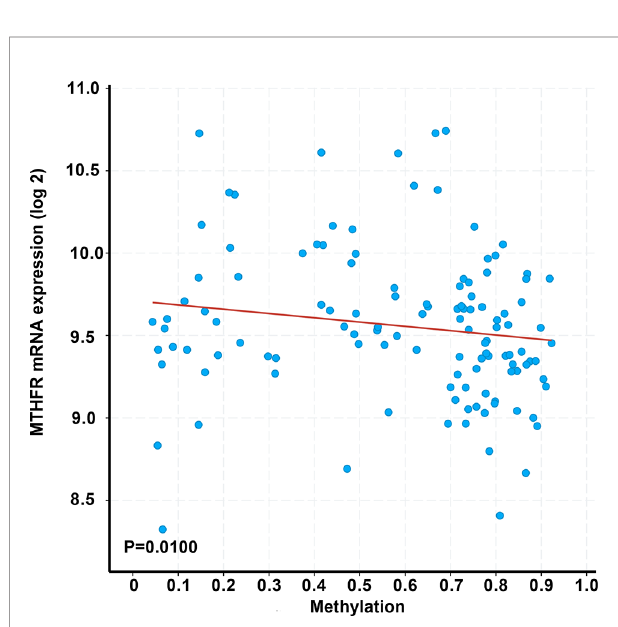
FIGURE 4 | Correlation between MTHFR transcriptional levels and its methylation in 123 patients with TETs. Correlations were estimated using Spearman ’ s bivariate correlation coef fi cient ( r = -0.24), with a p-value <0.05 considered as statistically signi fi